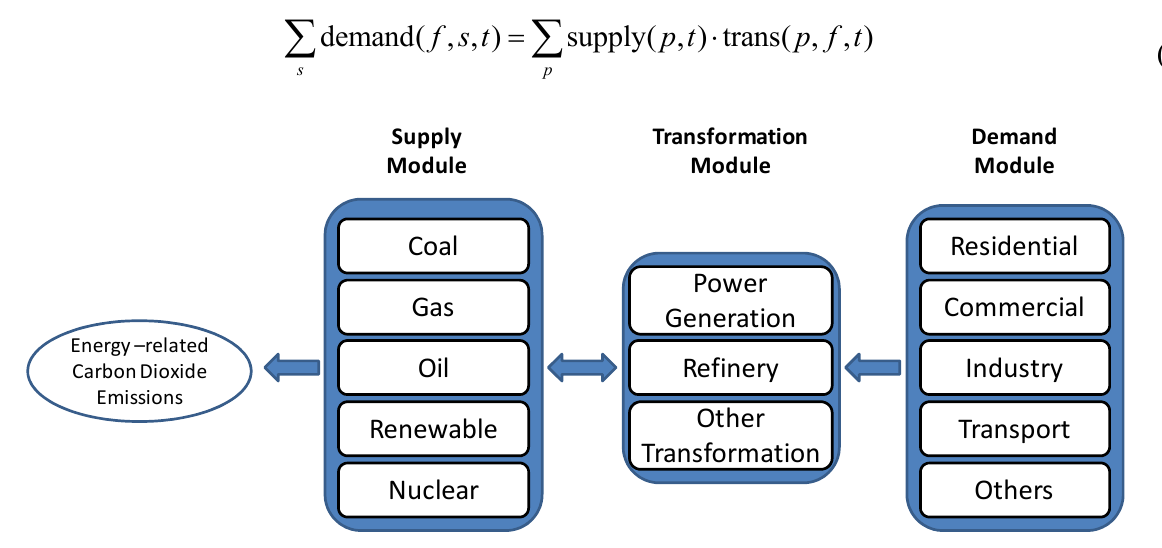
Figure 2. Bottom-up energy model